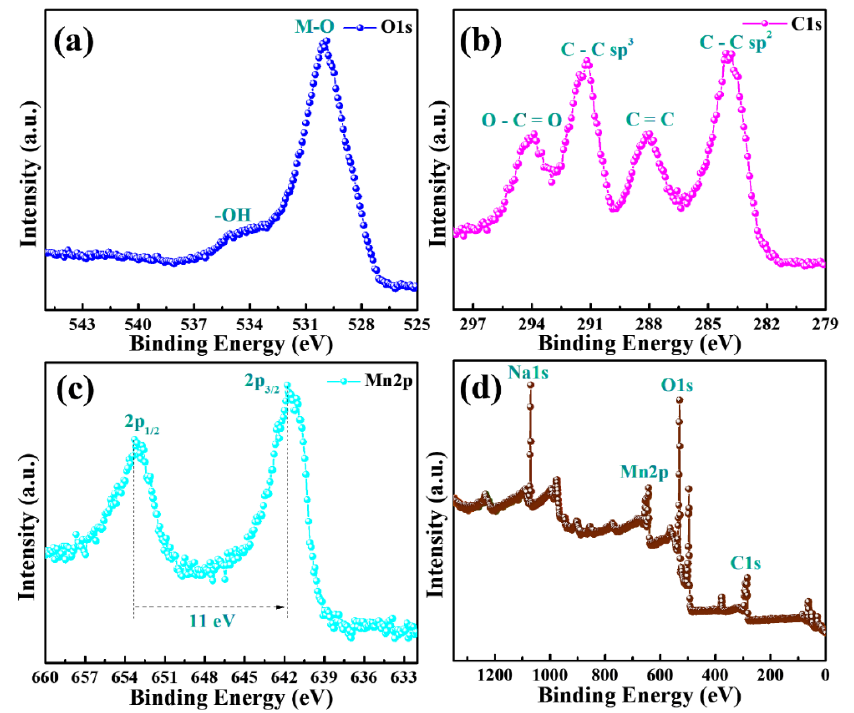
Figure 5. XPS results of MnO 2 @CE . ( a ) O 1 s, ( b ) C 1 s, and ( c ) Mn 2 p binding energy and ( d ) survey